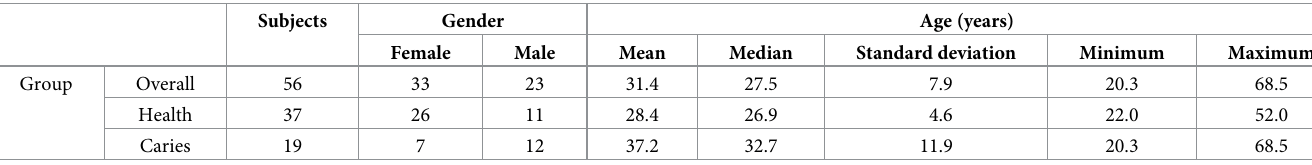
Table 1. Descriptive statistics on age and gender of